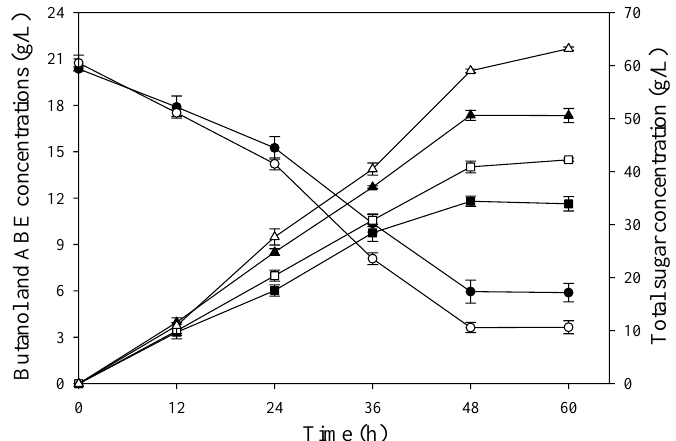
Figure 12. Batch butanol fermentations from SSJ medium with immobilized C. beijerinckii TISTR 1461